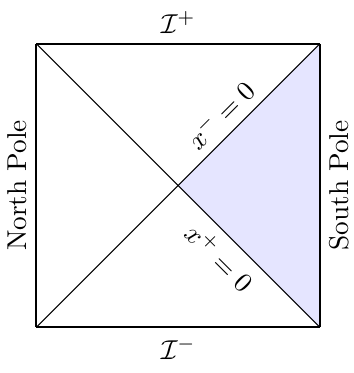
Figure 1 . Penrose diagram of de Sitter space with conformal matter in the Bunch-Davies state. The shaded region corresponds to the South Pole static patch. Here, we did not include the region corresponding to Φ < 0 because that will be absent from our final patched